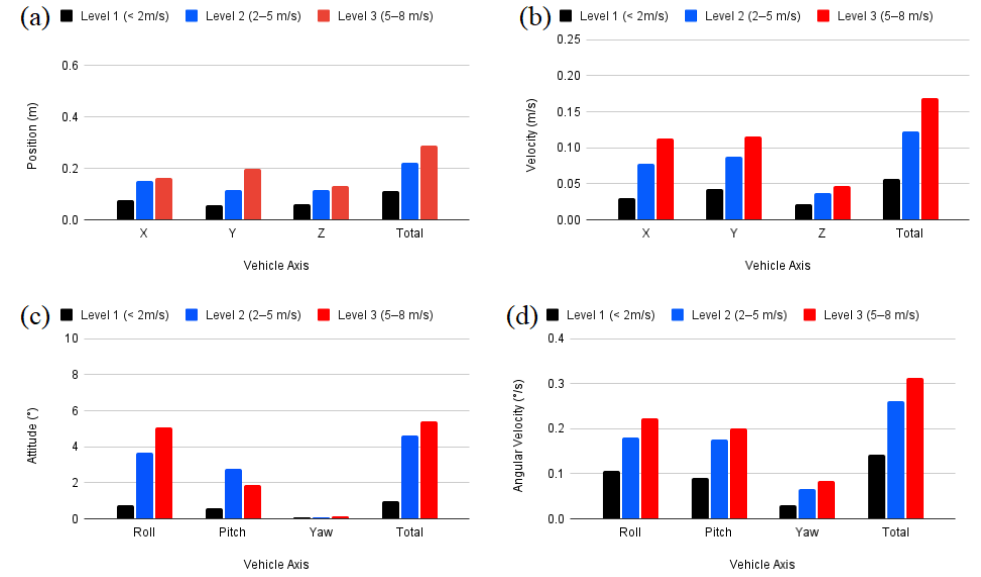
Figure 11. RMSE comparison between wind-still and windy conditions for DJI M600. All values are with respect to a set point. ( a ) RMSE on position. ( b ) RMSE on velocity. ( c ) RMSE on attitude. ( d ) RMSE on angular